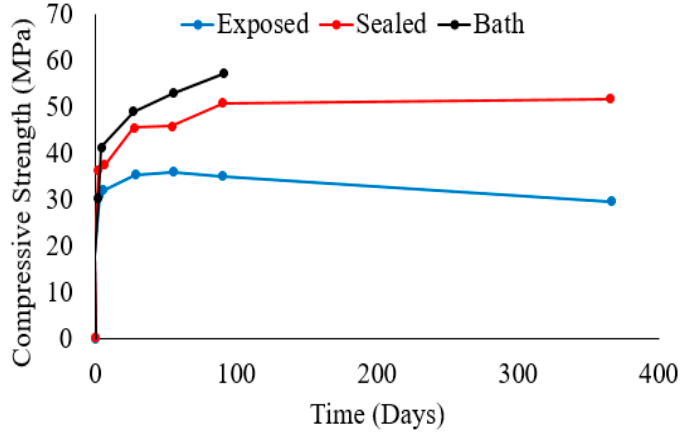
Figure 5. Strength evolution of concrete cylindrical samples with an AAS binder cured in air, sealed, or in a water bath [62].